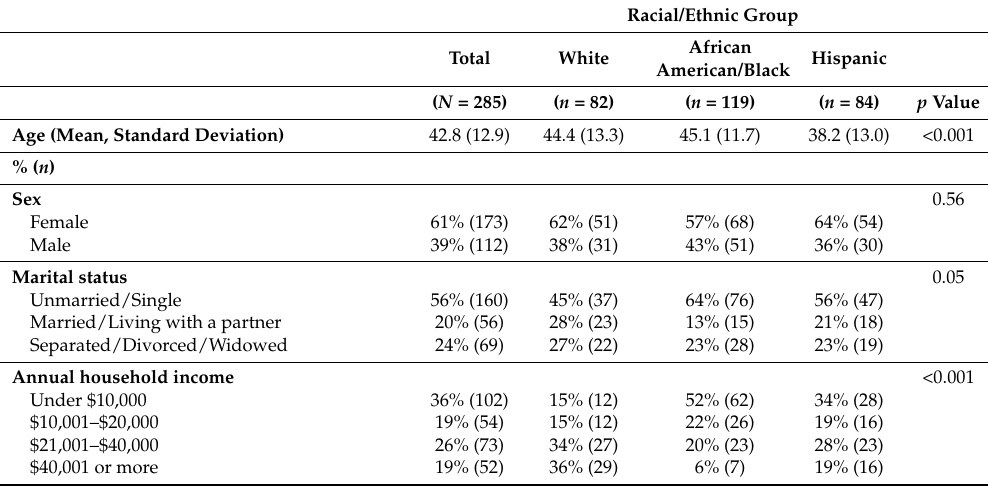
Table 1. Demographic characteristics by racial/ethnic